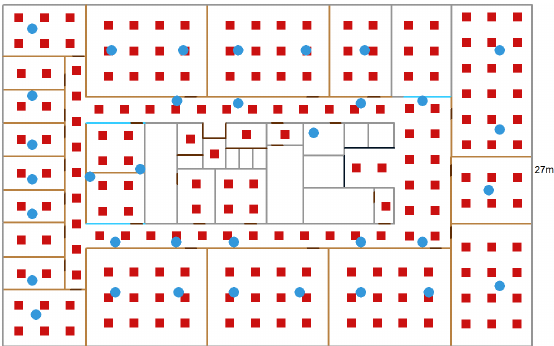
Figure 2. Floorplan of the office building with indication of walls, doors, elevators, access points (blue dots), and static validation locations (red squares) where a mobile node broadcasted packets at 5